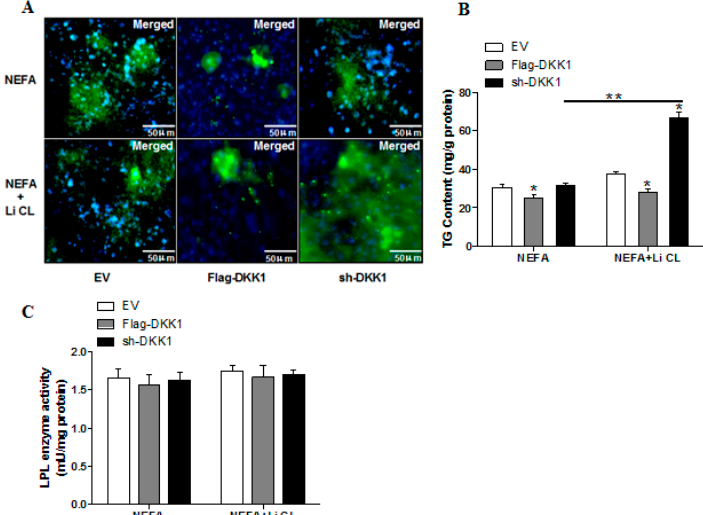
Figure 4. Activation of the Wnt/ β -catenin pathway promotes lipid accumulation in pig primary trophoblast cells challenged with 400 µ M NEFA. ( A ) Representative images (100 × ) of Bodipy staining after transfection with Flag-DKK1, sh-DKK1 for 48 h in primary trophoblast cells isolated from pig placentas. Cells were then incubated with 400 µ M NEFA or 20 µ M Li CL for 24 h ( n = 3). ( B ) Quantification of corresponding triglyceride (TG) in ( A ) by ELISA analysis ( n = 3). ( C ) LPL activity (mU/mg protein) after transfection with Flag-DKK1, sh-DKK1for 48 h in pig primary trophoblasts. Cells were then treated with400 µ M NEFA or 20 µ M Li CL for 24 h ( n = 3). Values are expressed as mean ± SEM. ** p < 0.01; * p < 0.05 compared with the control group. Flag-DKK1 group: over expression of DKK1 group, sh-DKK1 group: knock down of DKK1 group, Control: empty vector (EV)